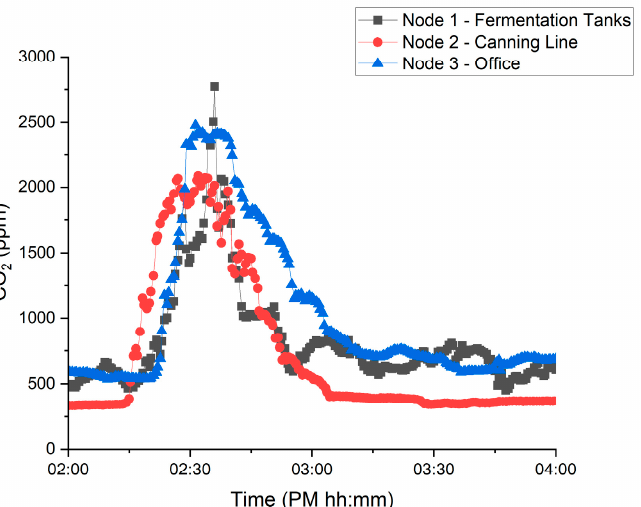
Figure 5. CO 2 Measured versus time for venting event 5b at 3 measurements locations within the brewery.